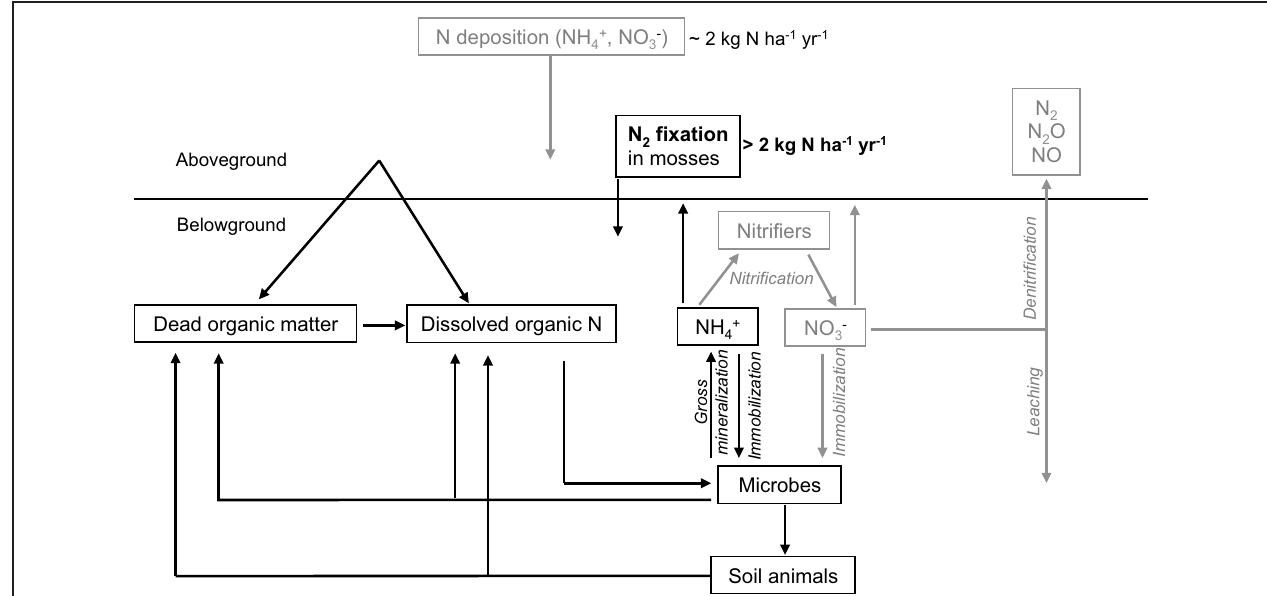
FIGURE 1 | A simplified overview of the N-cycle in boreal forests, including N 2 fixation in moss carpets as a candidate for filling the N-gap in boreal ecosystems. Boxes and arrows in gray indicate less common or less important pathways and sources of N in the boreal forest.